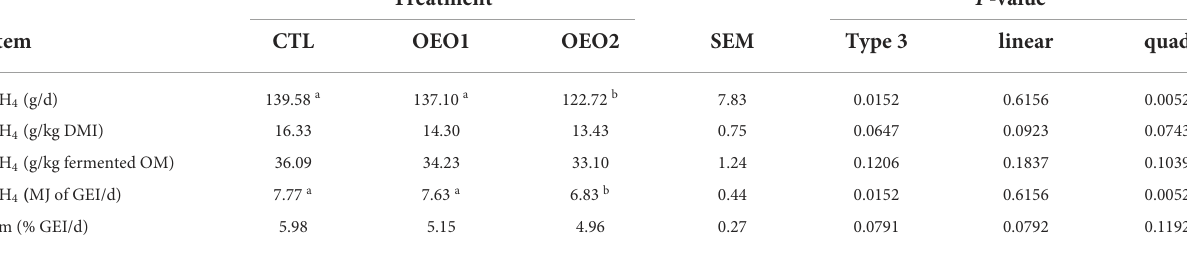
TABLE 9 Effect of orange essential oil (OEO) on the enteric CH 4 production of heifers ( n = 6). Treatment P